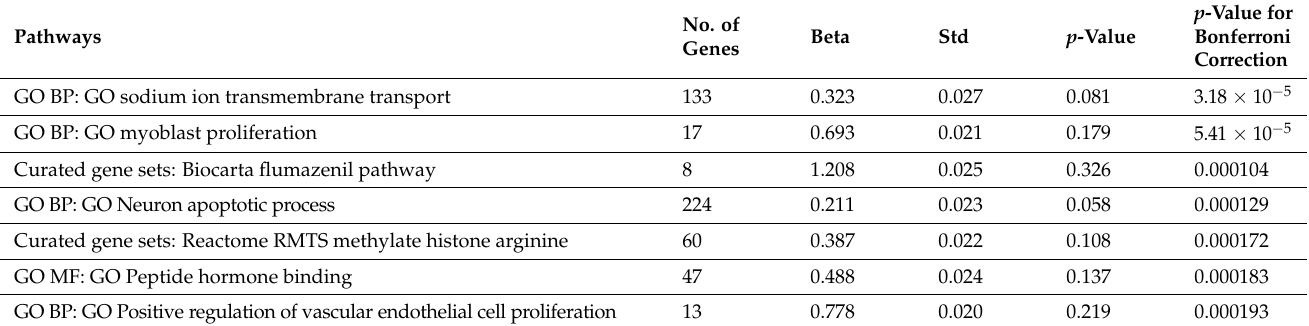
Table 4. Pathways related to genetic variants for body fat mass.